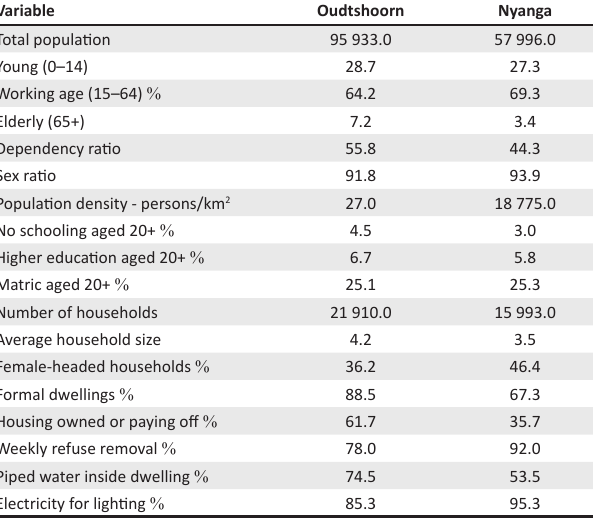
TABLE 1: Comparison of the 2011 National Census results.